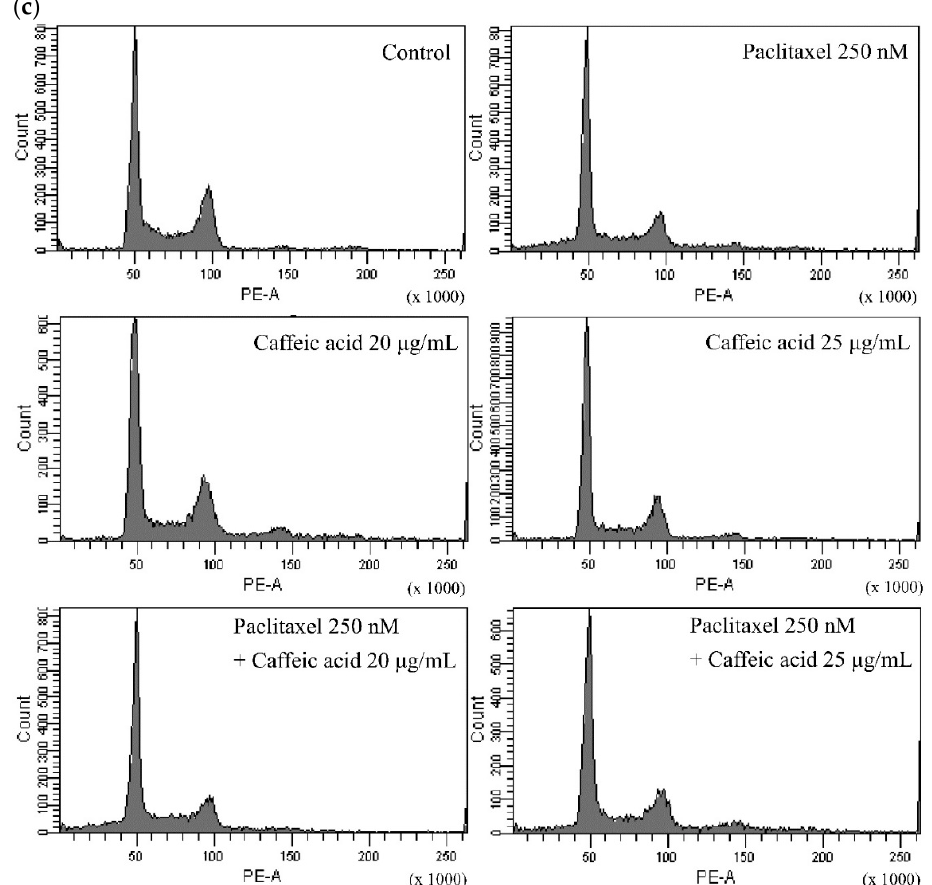
Figure 6. The cytotoxicity-enhancing effects of combinatorial treatment with caffeic acid. ( a ) The cell cycle distribution of 72 h treatment in ABCB1 /Flp-In TM -293 cell line. ( b ) The cell viability of KB/VIN under the treatment of chemotherapeutic drugs with or without caffeic acid. Data were presented as mean ± SE of at least three experiments, each in triplicate. * p < 0.05 as compared to the chemotherapeutic drug treatment (doxorubicin, paclitaxel, or vincristine) without caffeic acid. ( c ) The cell cycle distribution of 72 h treatment in KB/VIN cell line. Table 2. The reversal effects of caffeic acid on chemotherapeutic drug resistance in P-gp over- expressing cell line ABCB1 /Flp-In TM 293. Cell Line